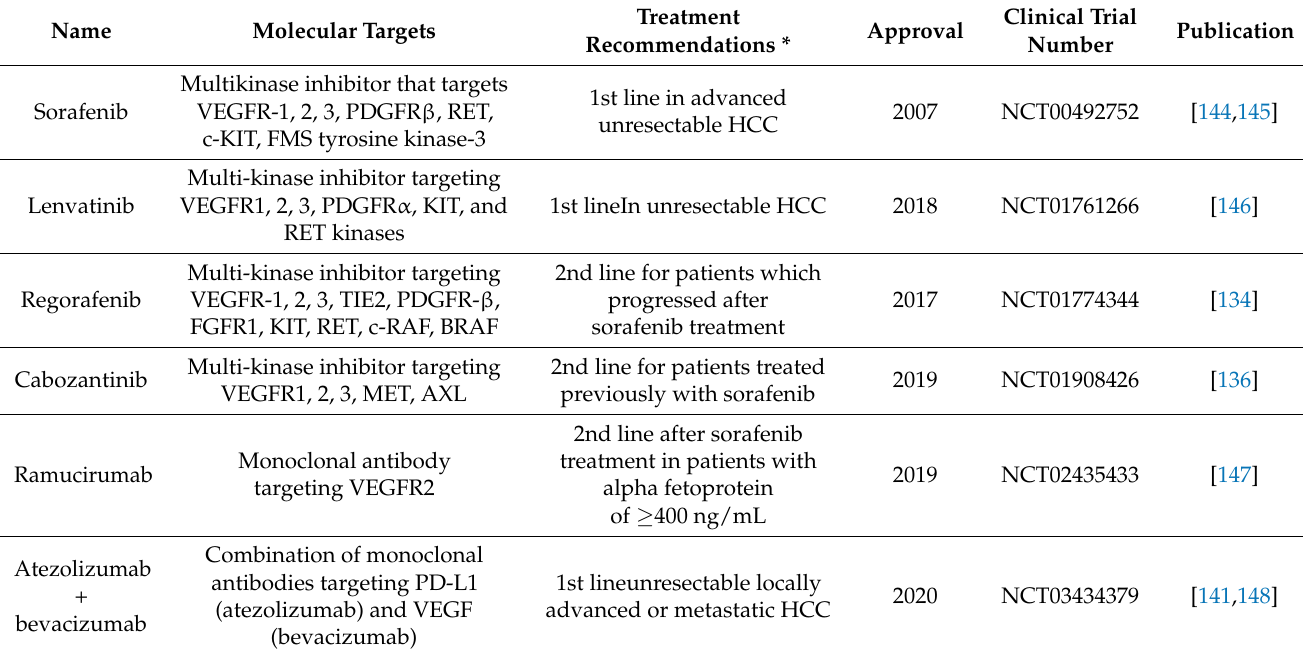
Table 2. Approved therapeutics for the treatment of